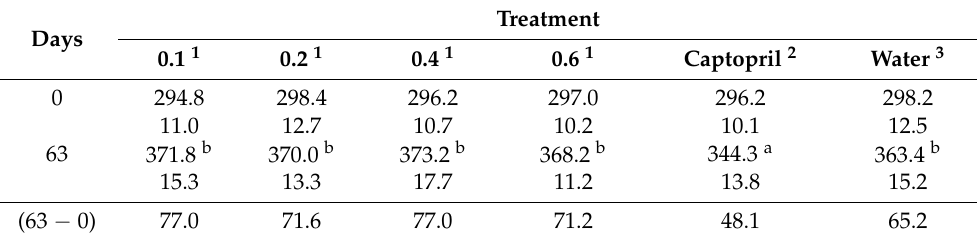
Table 4. Means and SE of body weight (g) in SHRs during the experimental